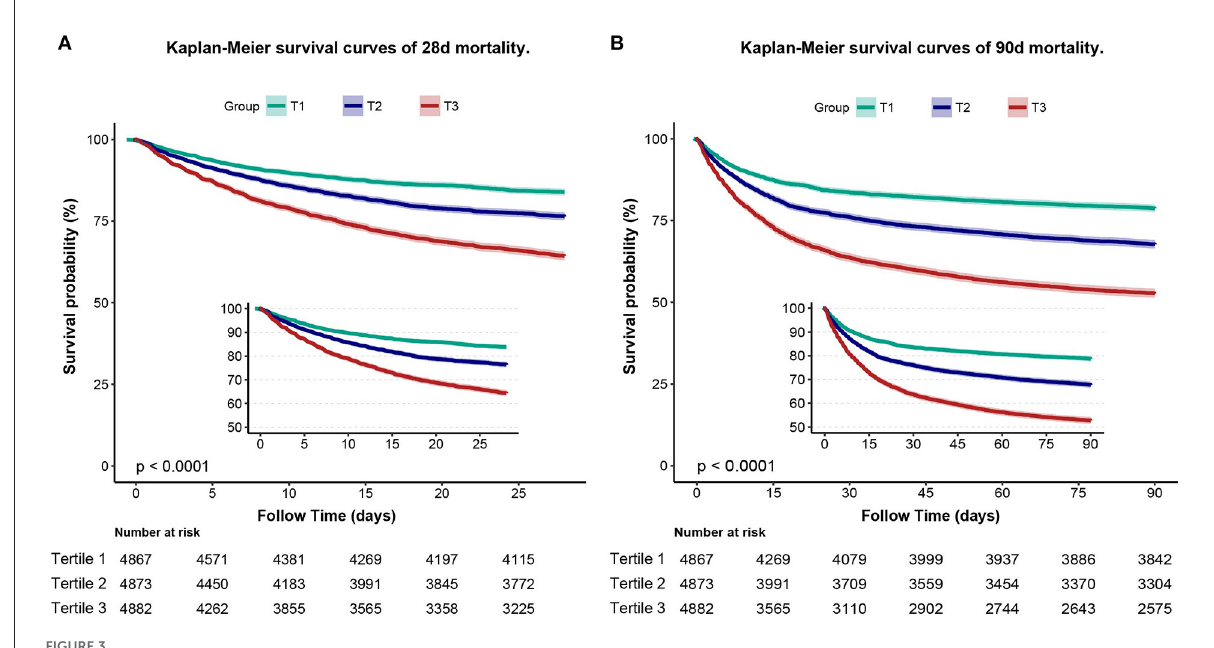
FIGURE3 Kaplan–Meier curve of 28-day mortality for patients with sepsis (A) . Kaplan–Meier curve of 90-day mortality for patients with sepsis (B)